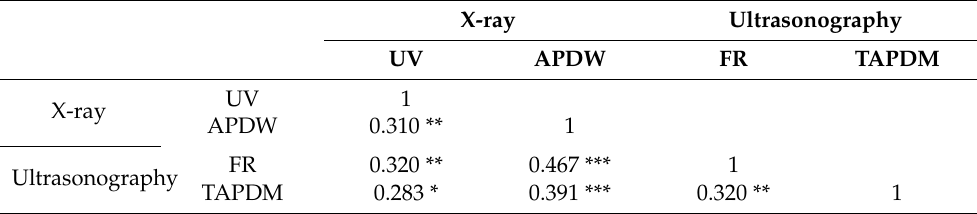
Table 4. Pearson’s correlation coefficient between ultrasonographic and roentgenographic features.